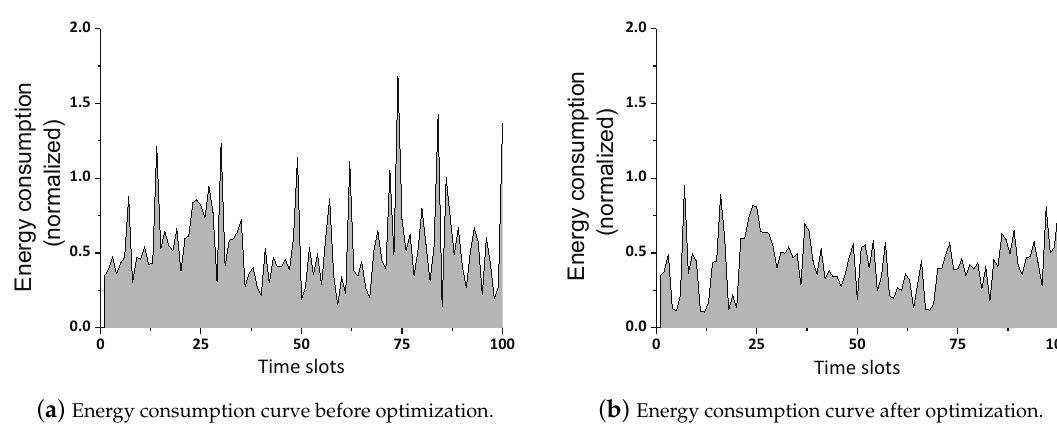
Figure 6. The comparison between before and after applying F-DQN.